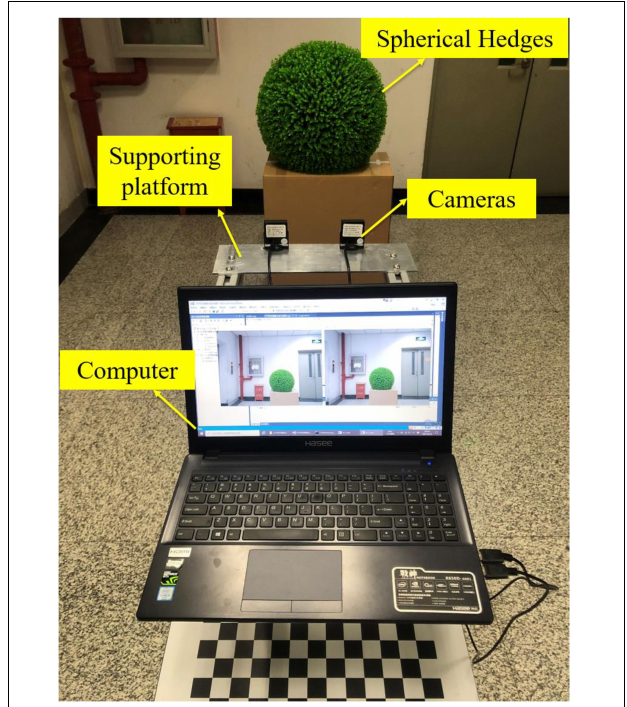
FIGURE 1 | Schematic diagram of the binocular vision system.